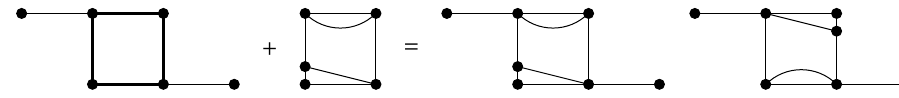
Figure 4. Demonstration of creation of tiles from S